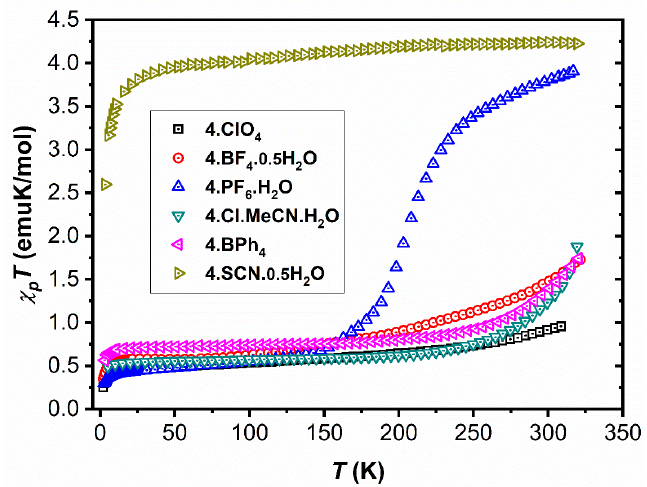
P T product in a field of 1 T.